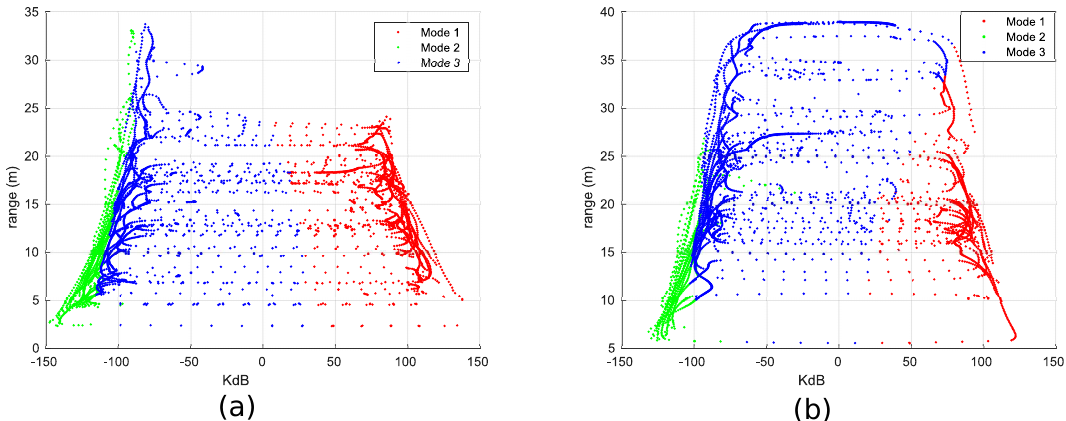
Figure 6. Mode segmentation (optimal number of sub-models) result of the car-following task in the range-KdB space, where a unique color represents a unique mode (sub-model) with its own distinctive motion-control characteristics: ( a ) Three-mode model identified for driver A; ( b ) three-mode model identified for driver B.